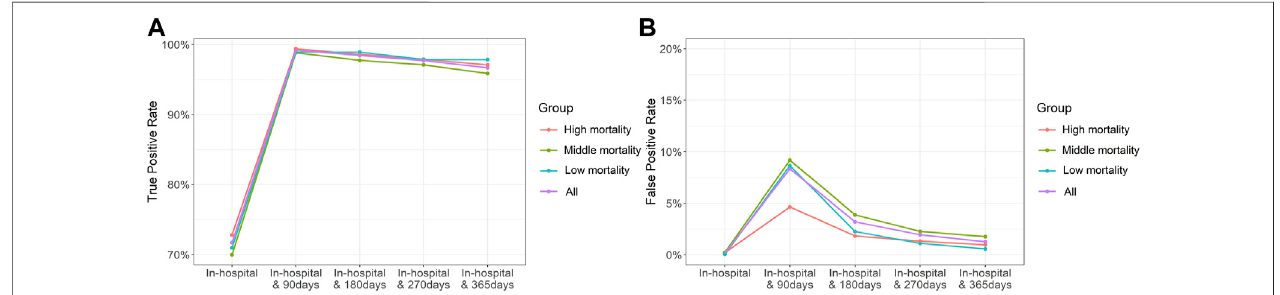
FIGURE 1 | True-positive (A) and false-positive (B) rates in the duration of 0 – 365 days following the last claim.